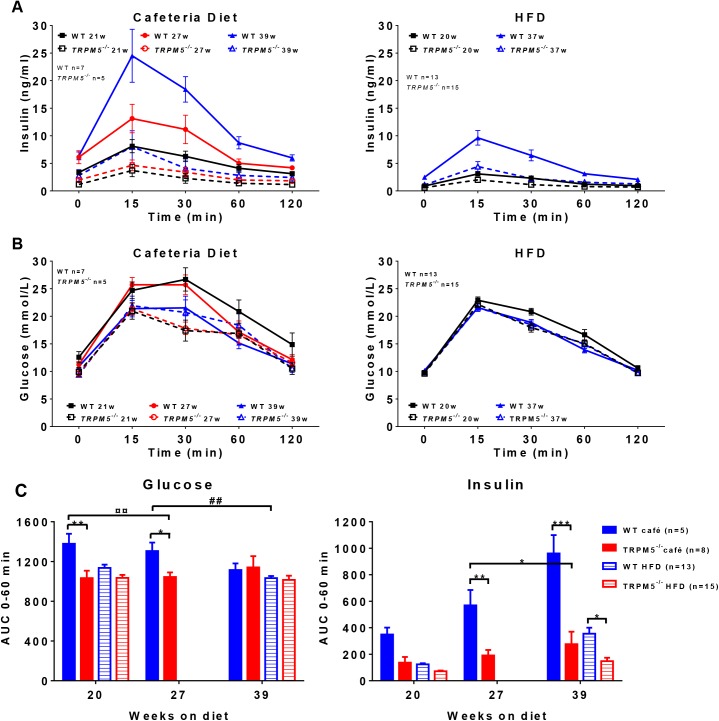
Effects of diet on glucose and insulin responses after an oral glucose tolerance test in female Trpm5
-/- and wild type mice.At different time points (weeks) after start on respective diet an oral glucose tolerance test was performed after a 4h fasting and (A) insulin and (B) glucose levels were recorded. (C) The area under the curve (AUC) was calculated for the first 60 min of the glucose and insulin response curves. Data are presented as mean ± SEM, *p<0.05, **p<0.01, ***p<0.001, Trpm5
-/- vs wild type at corresponding age and diet, ¤p<0.05, ¤¤¤p<0.001,Trpm5
-/- vs wild type mice at corresponding bodyweight and diet, ##p<0.01 cafeteria diet vs HFD for respective genotype (ANOVA with Bonferroni post-hoc test).